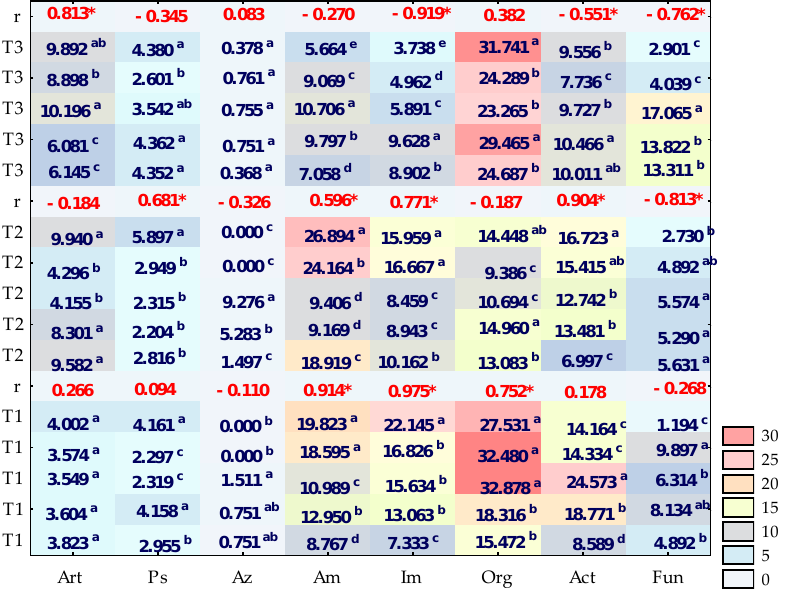
Figure 2. Number of microorganisms in soil contaminated with o -cresol on day 15, 30 and 45 of the experiment (cfu 10 n kg −1 DM of soil); Org—organotrophic bacteria (10 9 ), Act—actinomycetes (10 9 ), F—mold fungi (10 7 ), Ps— Pseudomonas sp. (10 8 ), Art— Arthrobacter sp. (10 8 ), Im—nitrogen-immobi- lising bacteria (10 8 ), Am—ammonifying bacteria (10 8 ) and Az— Azotobacter sp. (10 3 ). Homogeneous